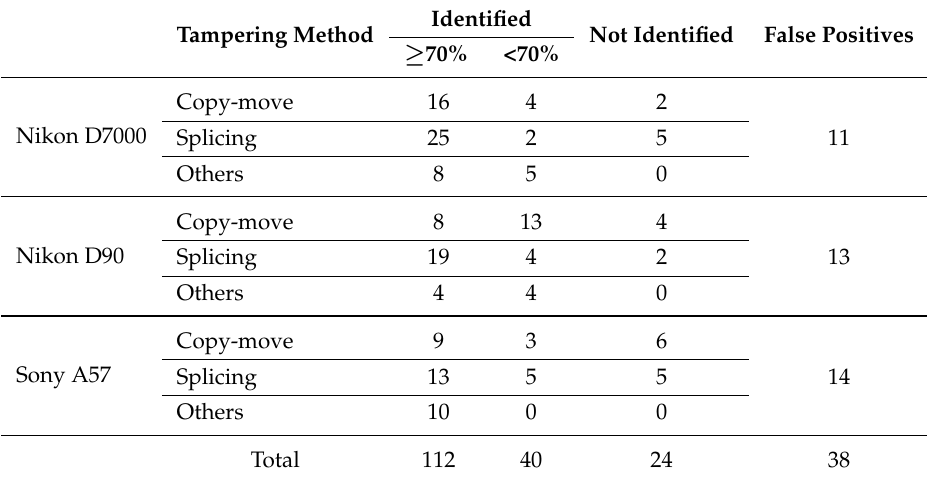
Table 1. Detection per tampering method and